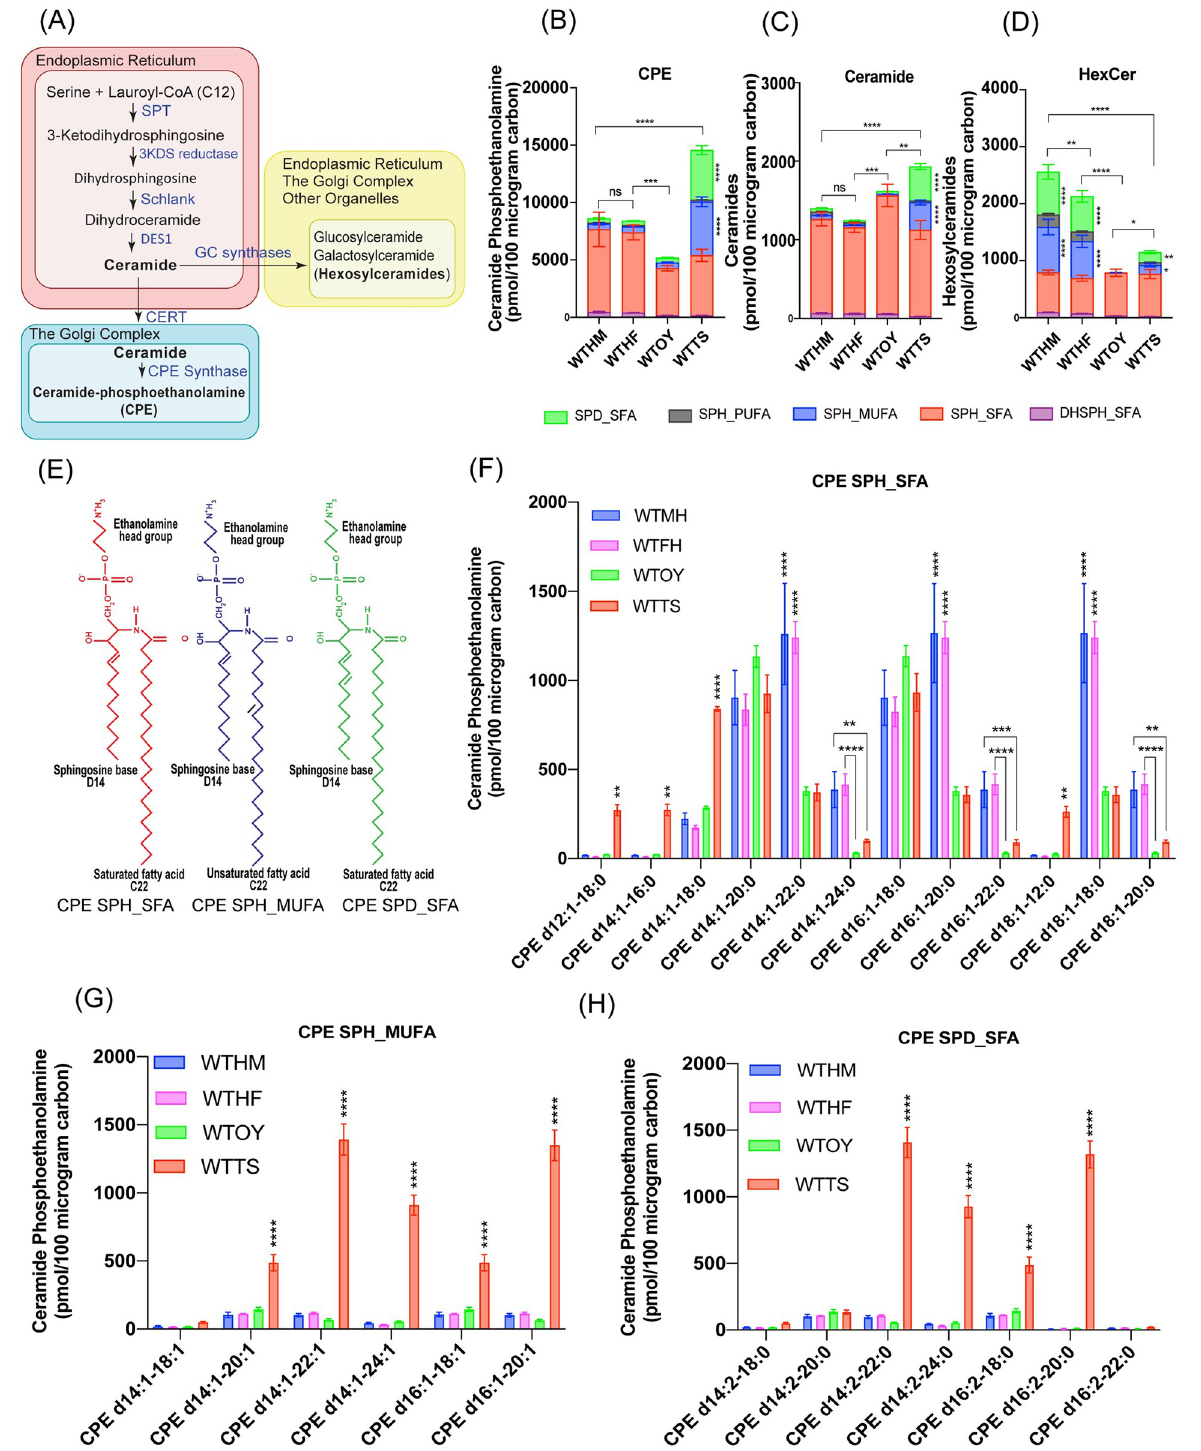
Fig 1. Sphingolipid analysis in wild-type Drosophila tissues. AU : AbbreviationlistshavebeencompiledforthoseusedinFigs 1 (cid:0) 8 andS 1 ; S 3 ; andS 5 : Pleaseverifythatallentriesarecorrect : (A) De novo sphingolipid biosynthetic pathway. De novo sphingolipid biosynthetic pathway begins with condensation of an amino acid serine and a fatty acid, lauryl-CoA into 3KDS by SPT complex in the membranes of ER. 3KDS is reduced to dihydrosphingosine by 3KDS reductase. Dihydrosphingosine is acylated to produce dihydroceramide by Schlank. Dihydroceramide is desaturated by Δ 4 desaturase (DES1) resulting in the formation of ceramide. Ceramide acts as a precursor for the biosynthesis of complex sphingolipids both in the ER and Golgi complex. Ceramide is actively transported to Golgi by CERT. In the trans Golgi lumen, ceramide is